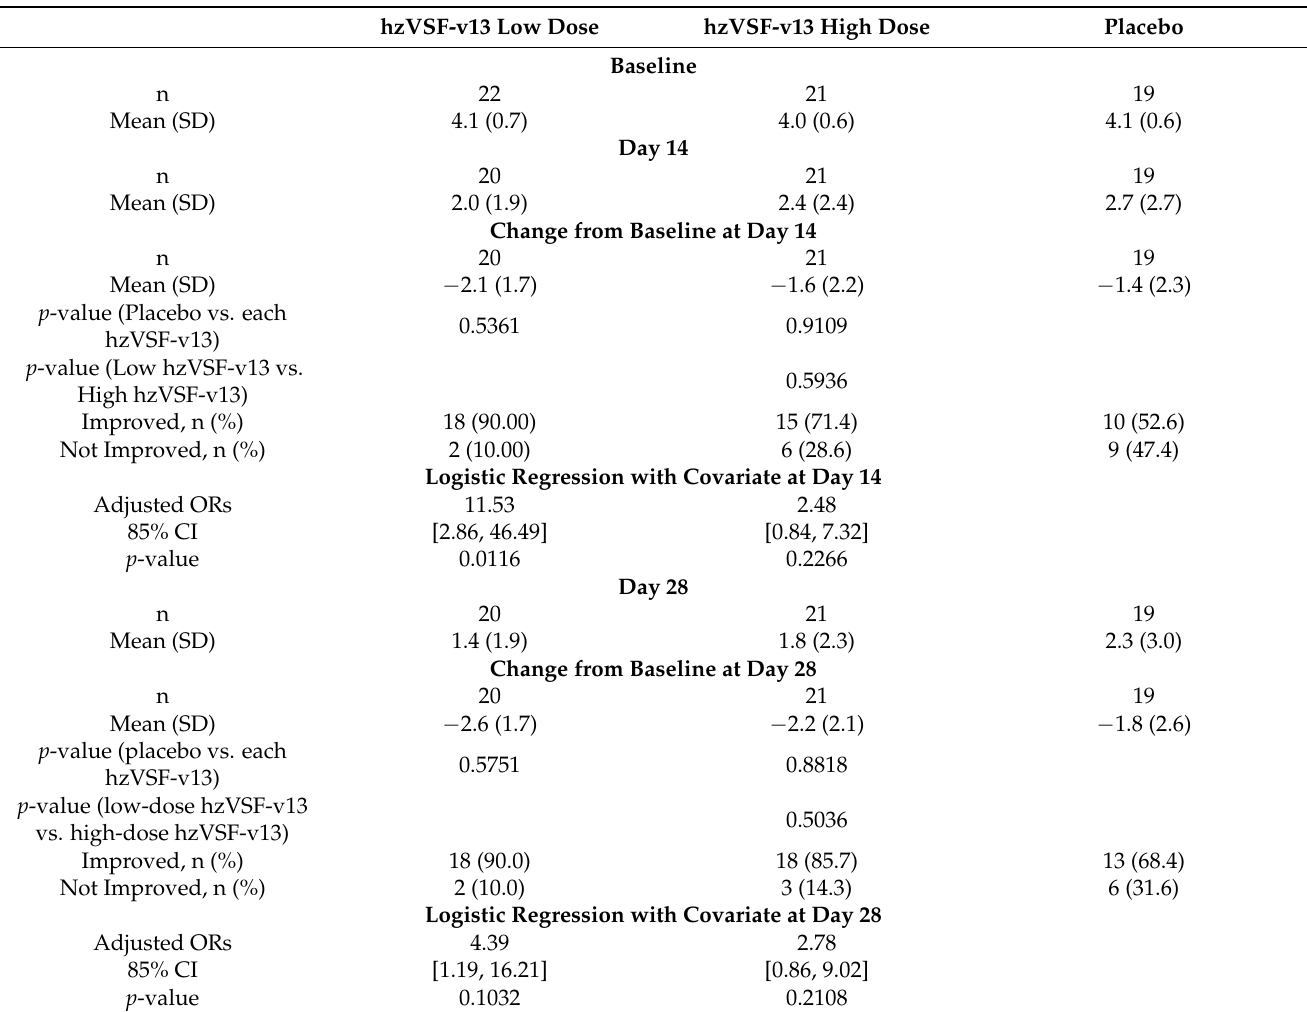
Table 4. Changes from baseline in the WHO ordinal scale for clinical improvement